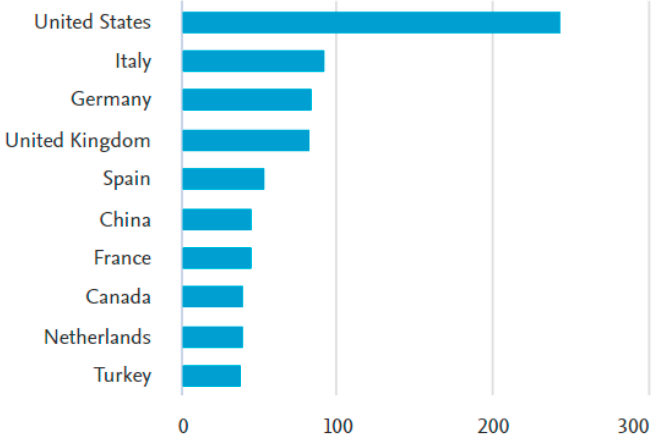
Figure 3. Top 10 countries or regions reporting studies on musculoskeletal system and ultrasound examination. Total studies of the top 10 countries = 753 papers.